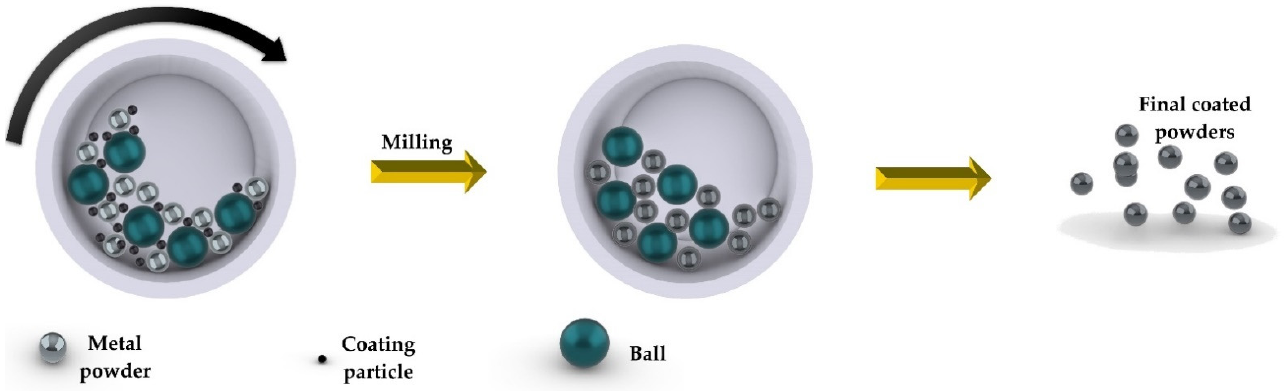
Figure 2. Schematic diagram of ball milling process for coating powders, the objects in figures are not in scale.